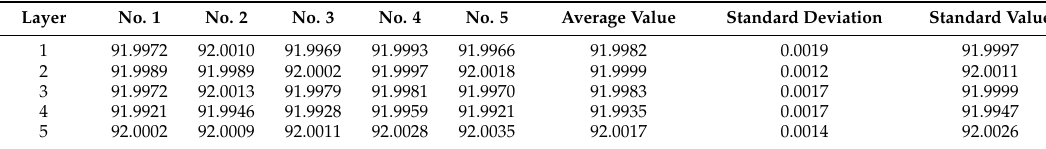
Table 3. Measuring data of Engine Block 2# (mm).